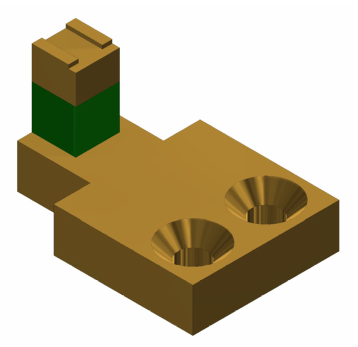
Figure 3. A 3D CAD model of the